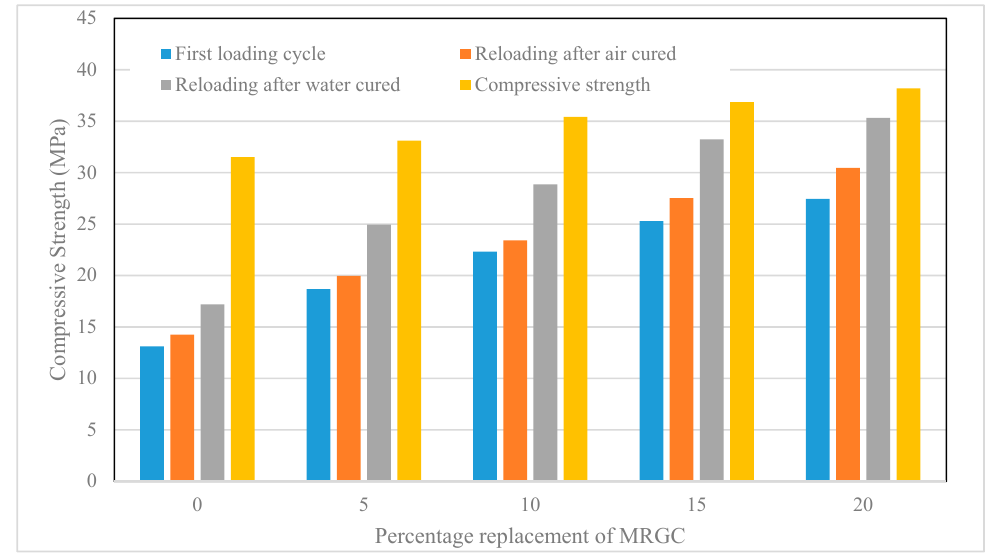
Figure 4. Compressive strength regained due to a crack healing effect of MRGC.